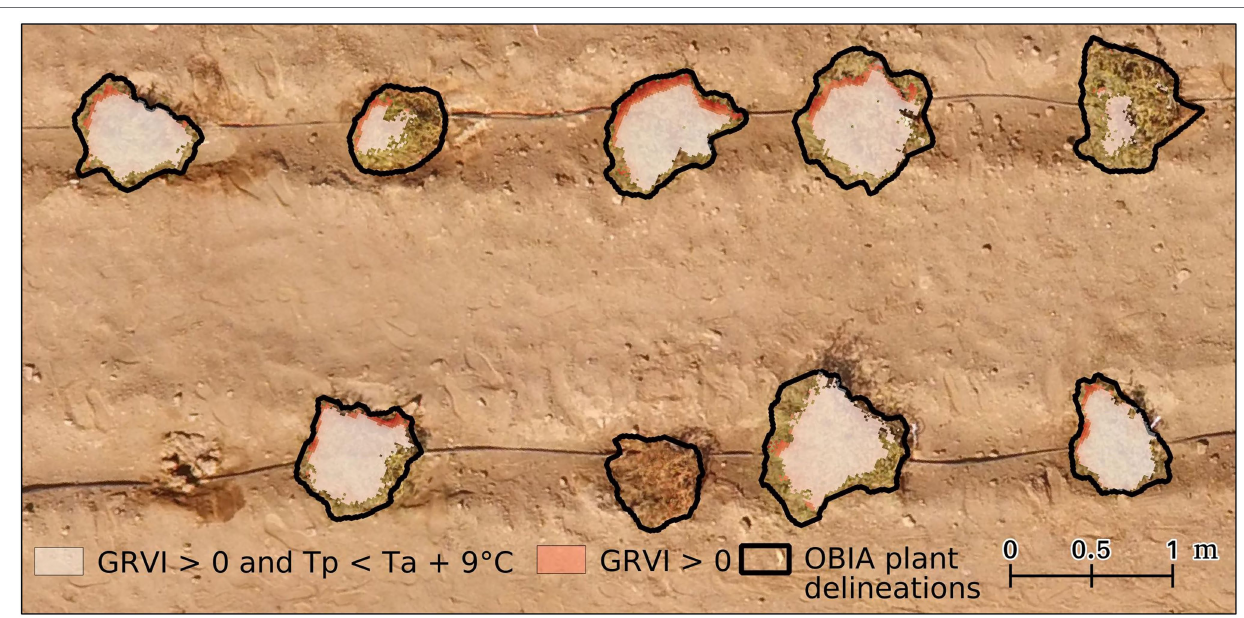
FIGURE 3 | An example of the vegetation mask where the GRVI was greater than 0 (i.e., indicating vegetation) and with pixels greater than air temperature (T a ) + 9 ° C dropped. Data are overlaid on a red, green, and blue image of six plants in a range of conditions in control plot 2 on January 14, 2018. Note light red on the edge plant corresponds to GRVI > 0 pixels warmer than T a + 9 °